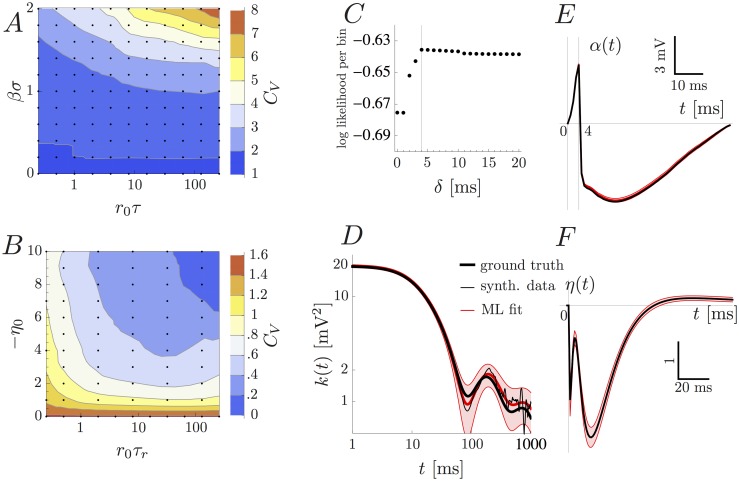
The model has a rich dynamical repertoire (A, B) and can be correctly fitted to synthetic data (C-F).(A, B) The coefficient of variation (C
V) of the inter-spike interval distribution is computed for parameter values shown as black dots and then linearly interpolated. (A) The C
V of a simple version of the AGAPE (k(t) = σ
2
e
 − t/τ, α = η = 0) as a function of the model parameters (membrane time-constant τ, baseline firing rate r
0 and coupling strength βσ). (B) C
V of the AGAPE model with an exponentially adaptive process with fixed membrane time-constant, firing rate and coupling (βσ = r
0
τ = 1) as a function of the parameters describing adaptation, namely adaptation strength η
0 and time-constant τ
r. (C, D, E, F) Synthetic data is sampled from the AGAPE model with GP (D), spike-related (E), and adaptation (F) kernels as depicted in black, and δ = 4 ms, r
0 = 4.15 Hz, β = 0.374 mV − 1. Then the AGAPE is fitted to the synthetic data by maximum likelihood (ML). (C) The maximum log likelihood per bin as a function of the parameter δ has its maximum at the ground truth value δ = 4 ms. (D, E, F) The ML estimates (red) of the GP, spike-related and adaptation kernels lie within two standard deviations (red shaded regions, estimated by means of the observed Fisher information) from the ground truth.